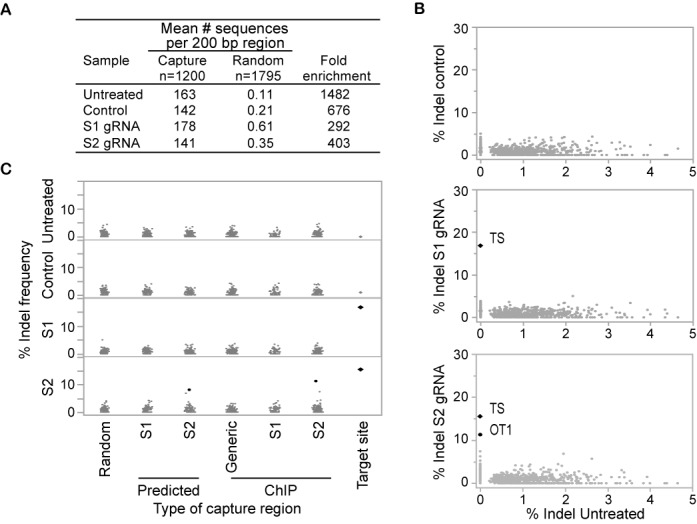
Sequence capture identifies indels at the target sites and one off-target site. (A) Sequence coverage of capture regions. The mean number of sequence reads mapping to each 200 bp target region (n = 1200) is shown for untreated Neuro-2a cells, cells treated with catalytically active Cas9 and non-functional empty gRNA, S1 gRNA or S2 gRNA. As a comparison, coverage was also calculated for a random set of non-targeted genomic regions of the same size (n = 1795). Fold enrichment of capture regions as compared to random regions is shown. (B) Bivariate analysis of percent indels relative to the total number of reads per target region. The top panel depicts a comparison of Neuro-2a control cells expressing catalytically active Cas9 and non-functional gRNA to untreated Neuro-2a. The middle panel shows a comparison of cells treated with S1 gRNA against untreated Neuro-2a cells. High occurrence of indels is observed for the target site (TS). The bottom panel shows a comparison of cells treated with S2 gRNA to untreated Neuro-2a cells. High indel frequencies are observed for one off-target site (OT1) in addition to the TS. Indels at the S1 and S2 target sites and the OT1 S2 off-target site are statistically significant as determined by Fisher's exact test (n = 1200, p < 0.01). (C) Occurrence of indels at computationally predicted off-target sites and Cas9-bound sites identified by ChIP-seq is compared to indel frequency at the target site and at random genomic regions. Indel frequencies for each category are compared across the four treatments: untreated Neuro-2a cells, control Neuro-2a cells treated with Cas9 and empty gRNA (top two panels) or with Cas9 and S1 gRNA or S2 gRNA (bottom two panels). Indels with statistical significance as determined by Fisher's exact test (n = 1200, P < 0.01) are indicated as black dots.